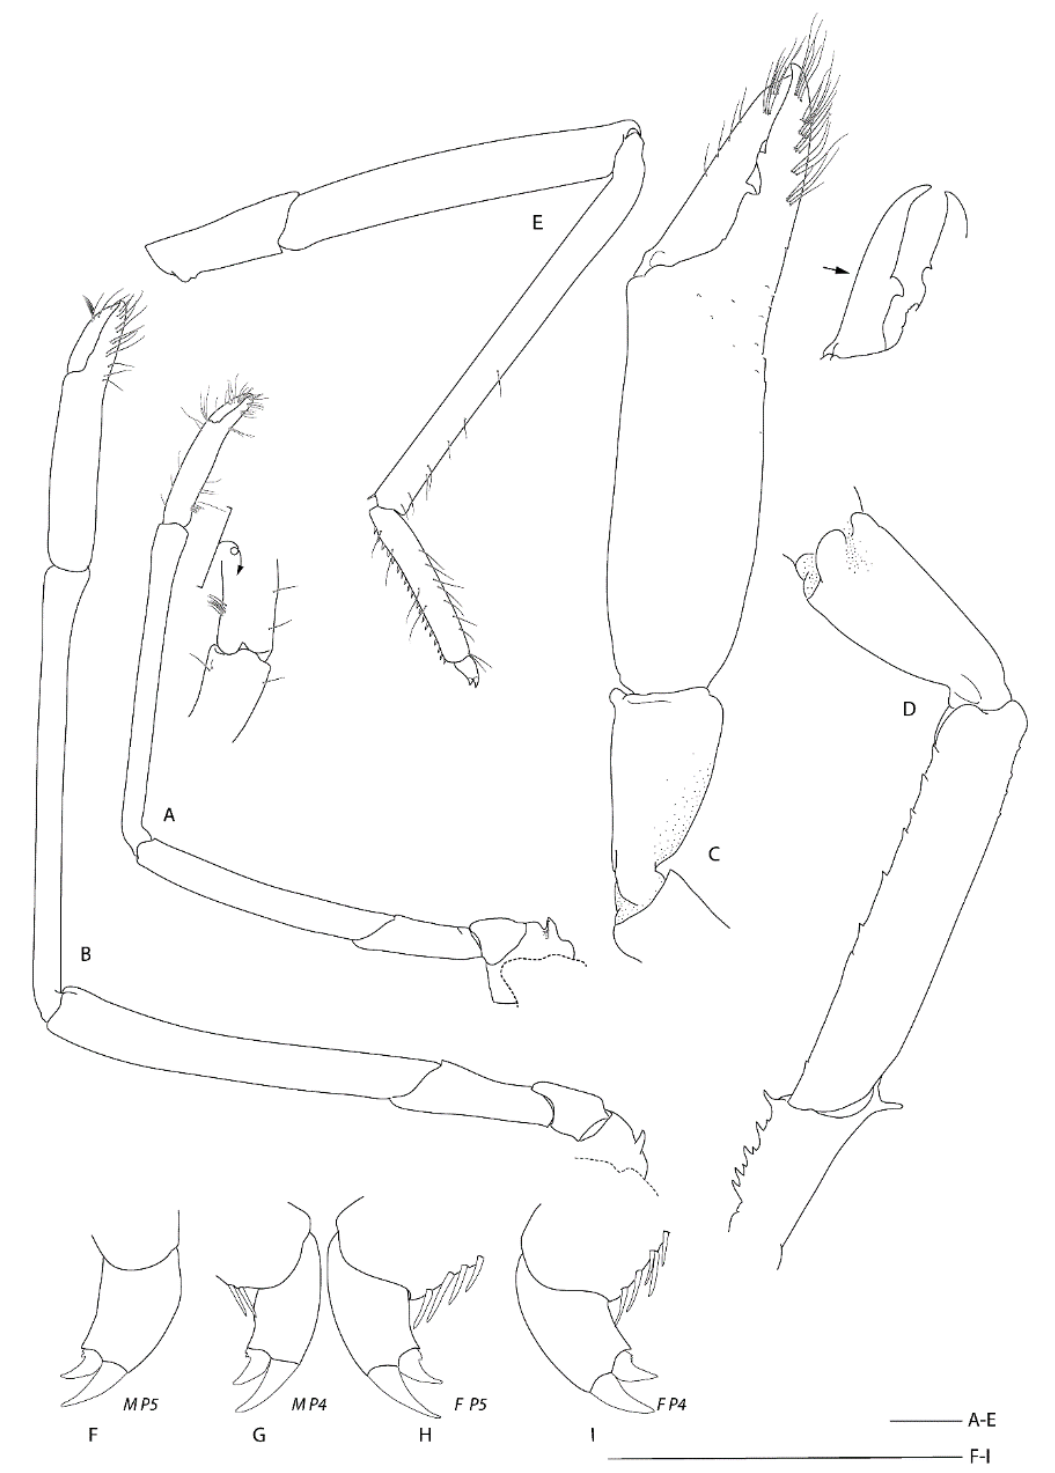
Figure 13. Spongicoloides sonne sp. nov., ( A – D , H , I ): holotype F ov. (NIWA 127110). F, G: allotype M (NIWA127111). ( A ) Right P1, lateral, with rotated inset of merocarpal setiferous organ. ( B ) Right P2, lateral. ( C ) Distal P3, right, lateral, with inset detail of incisor margin of fingers. ( D ) Proximal P3, right, mesial. ( E ) Right P4, lateral. ( F – I ) Dactyli and distal propodi of P4–5 for male ( M ) allotype and female ( F ) holotype. Scale = 2 mm.